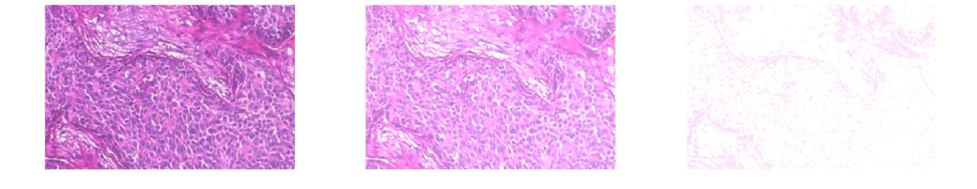
Figure 7. Example of brightness data augmentation operations (left = original, middle = brightness + 50, right = brightness +